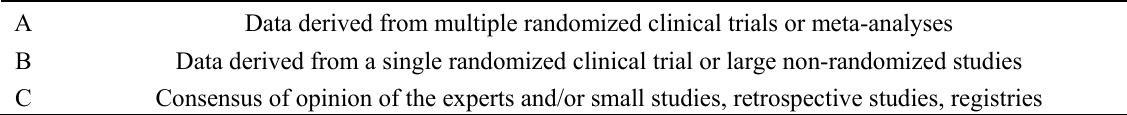
Table 1. Levels of evidence.